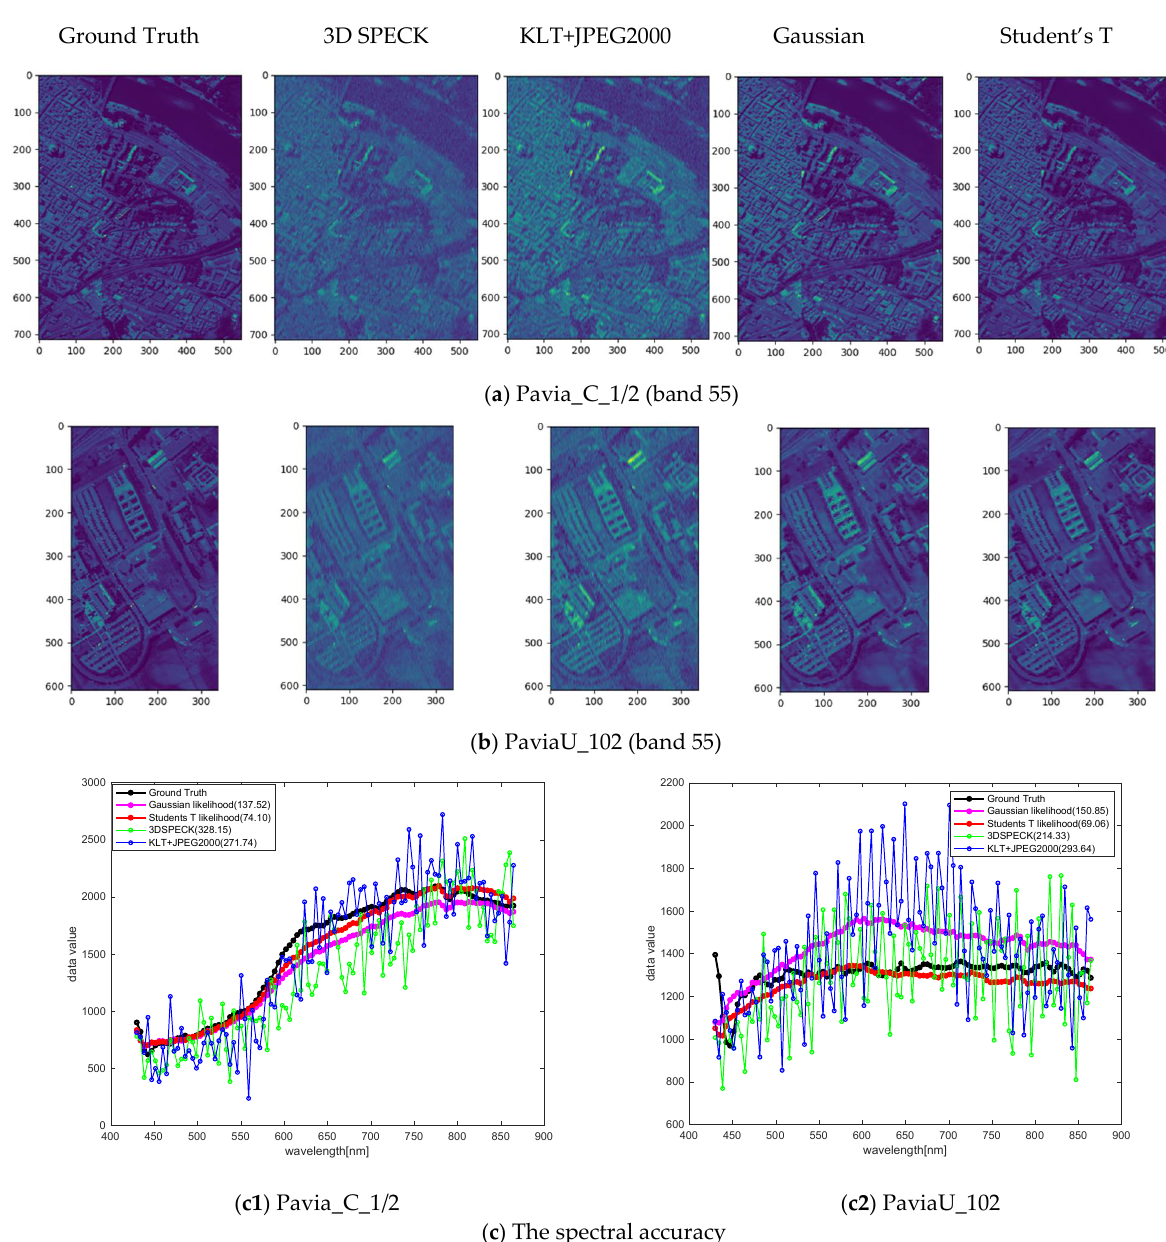
Fig. 10. The spatial and spectral fidelity on ROSIS-Pavia dataset for relatively low bit rates. The first row is the results of Pavia_C_1/2, while the second row is the results of PaviaU_102. The visualization of the spatial domain shows the reconstructed quality of band 55. The last row shows the spectral accuracy of the white patches on ground truth, measured with RMSEs in parenthesis. We also show another four HSI datasets comparisons in Appendix B to demonstrate the superiority of our method for HSI compression across different spectral and spatial resolutions and sensors.